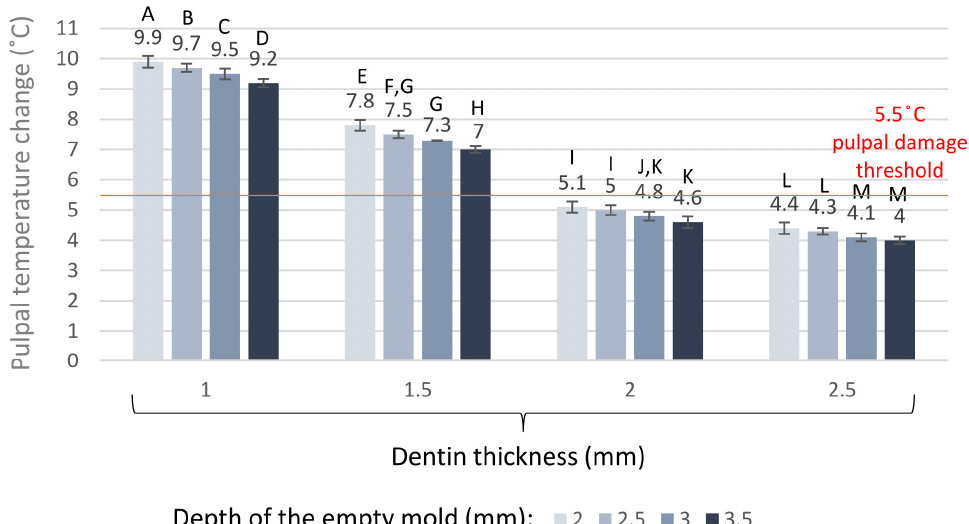
Figure 1. Intrapulpal temperature changes during light exposure of dentin adhesive through the different dentin thicknesses using the empty molds. Different capital letters (A–M) indicate statistically significant differences according to the one-way ANOVA and Tukey’s post-hoc test.